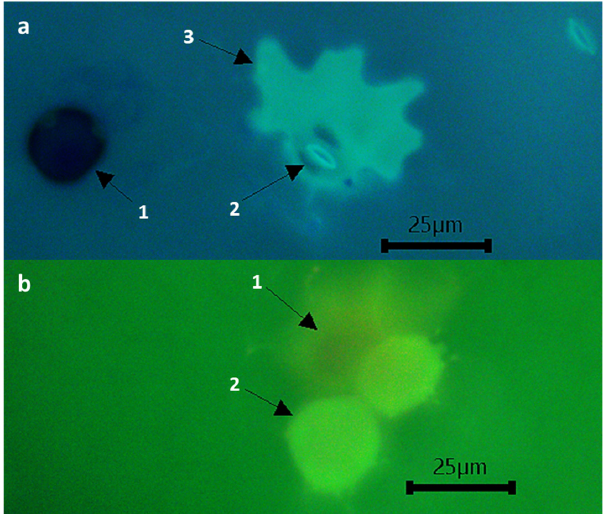
Figure 3. Different cells attacked by U. pisi colonies in PI273209 accession: ( a ) Epidermic tissue visualized with fluorescent blue filter at 48 h post inoculation showing a germinated urediospore (1), the stoma (2), and a dying epidermal cell (3); ( b ) Mesophyll tissue visualized with fluorescent green filter showing the substomatal space (1) and two dying mesophyll cells (2).